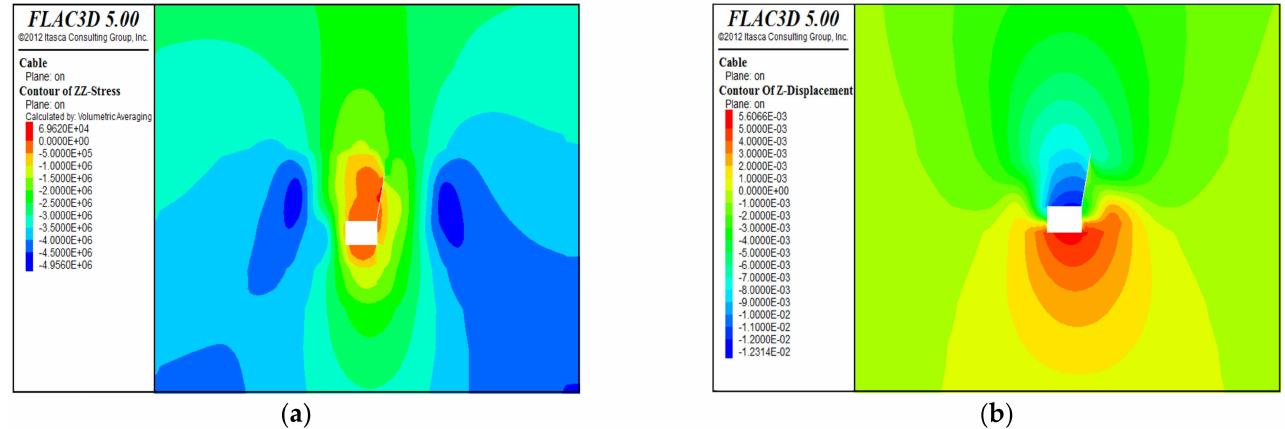
Figure 6. Distribution of vertical stress and vertical displacement at 5 m in front of the working face: ( a ) vertical stress distribution diagram; ( b ) vertical displacement distribution